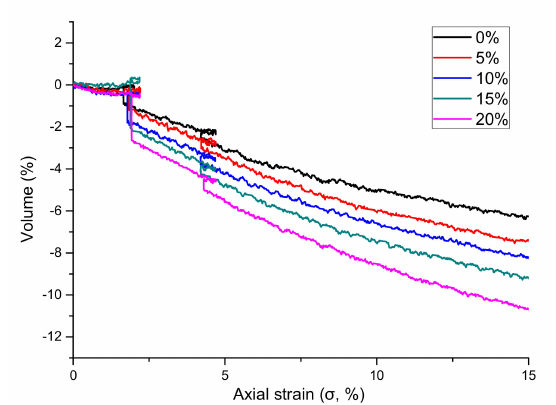
Figure 7. Volume–strain curves of sediments by clay content (%). The first stage represents axial strain rates of 0–2.2%, the middle stage accounts for rates of 2.2–4.7%, and the final stage represents strain rates of 4.7–15%. Di ff erent colors correspond to di ff erent clay